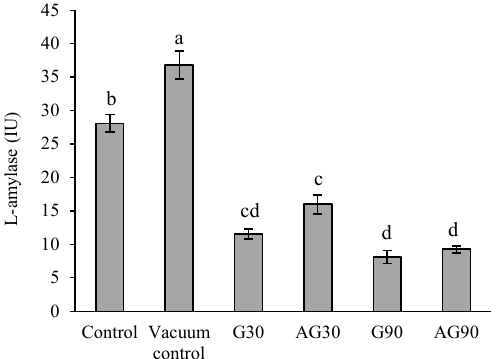
Figure 8. The activity of α -amylase enzyme in untreated (Control) seeds, seeds exposed to vacuum (Vacuum control), and CP-treated seeds in the glow regime for 30 s (G30) or 90 s (G90), and in the afterglow regime for 30 s (AG30) or 90 s (AG90). Displayed values are the mean ± SE of three repli- cations. Different letters (a–d) indicate statistically significant differences among treatments accord- ing to Duncan’s test ( p < 0.05).